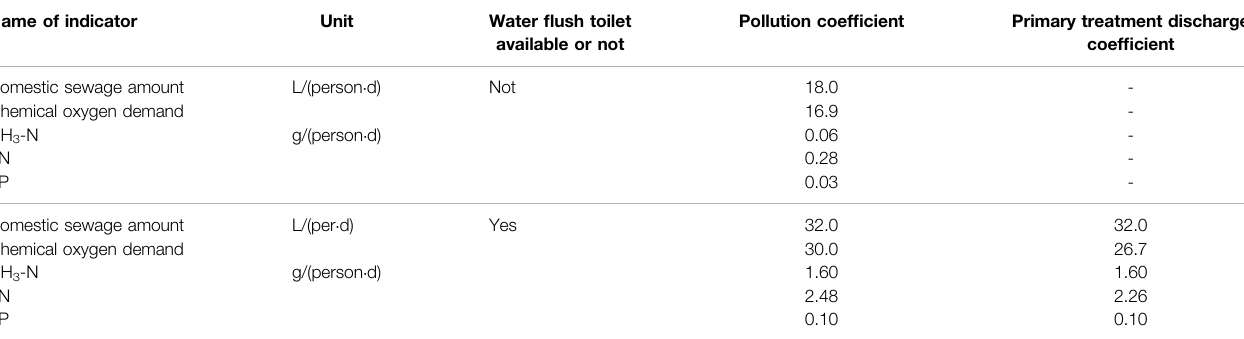
TABLE 2 | Production and discharge coef fi cients of domestic water pollutants of rural residents in the study areas. Name of